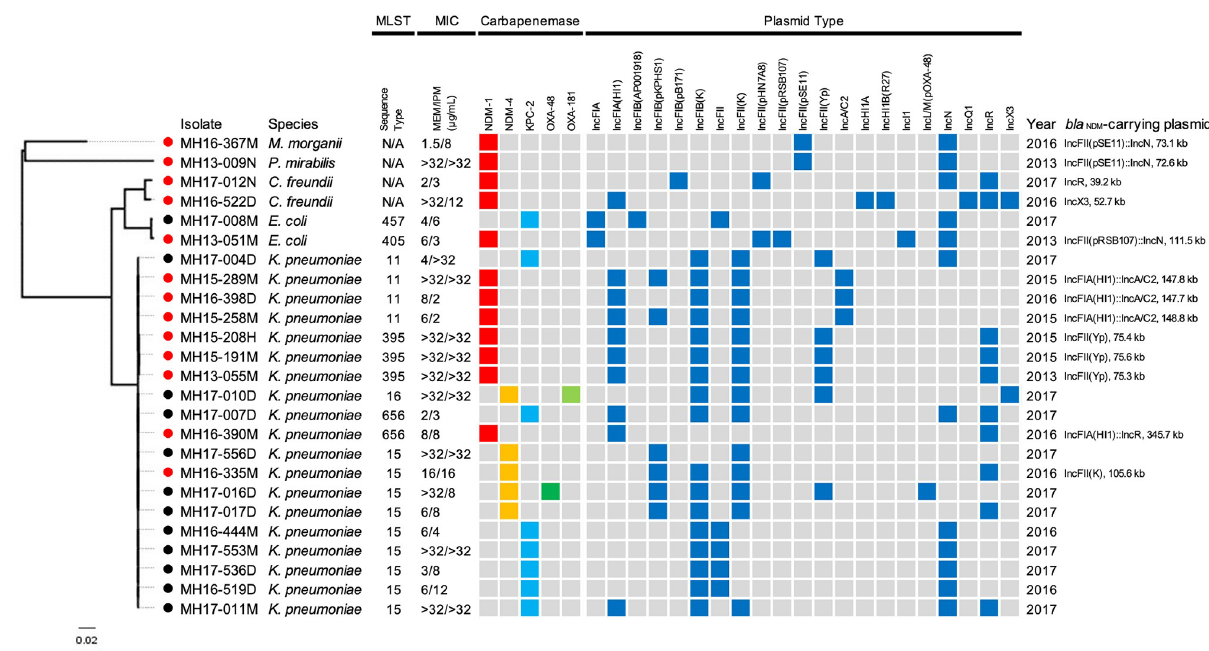
Fig 1. Carbapenem-nonsusceptible Enterobacterales isolates sequenced on Illumina systems. Red nodes, but not black nodes, show isolates subsequently sequenced with ONT MinION. Bar lengths represent the number of substitutions per site in the core genome constructed using the Roary pipeline (see Materials and methods). Sequence types of multilocus sequence typing (MLST) analysis determined from genomes, minimum inhibitory concentrations (MICs) of meropenem (MEM) and imipenem (IPM) of isolates, carbapenemase genes detected by ResFinder and replicon types detected by PlasmidFinder in genomes, years in which the bacteria were isolated, and replicon types and sizes of bla NDM -carrying plasmids are shown.